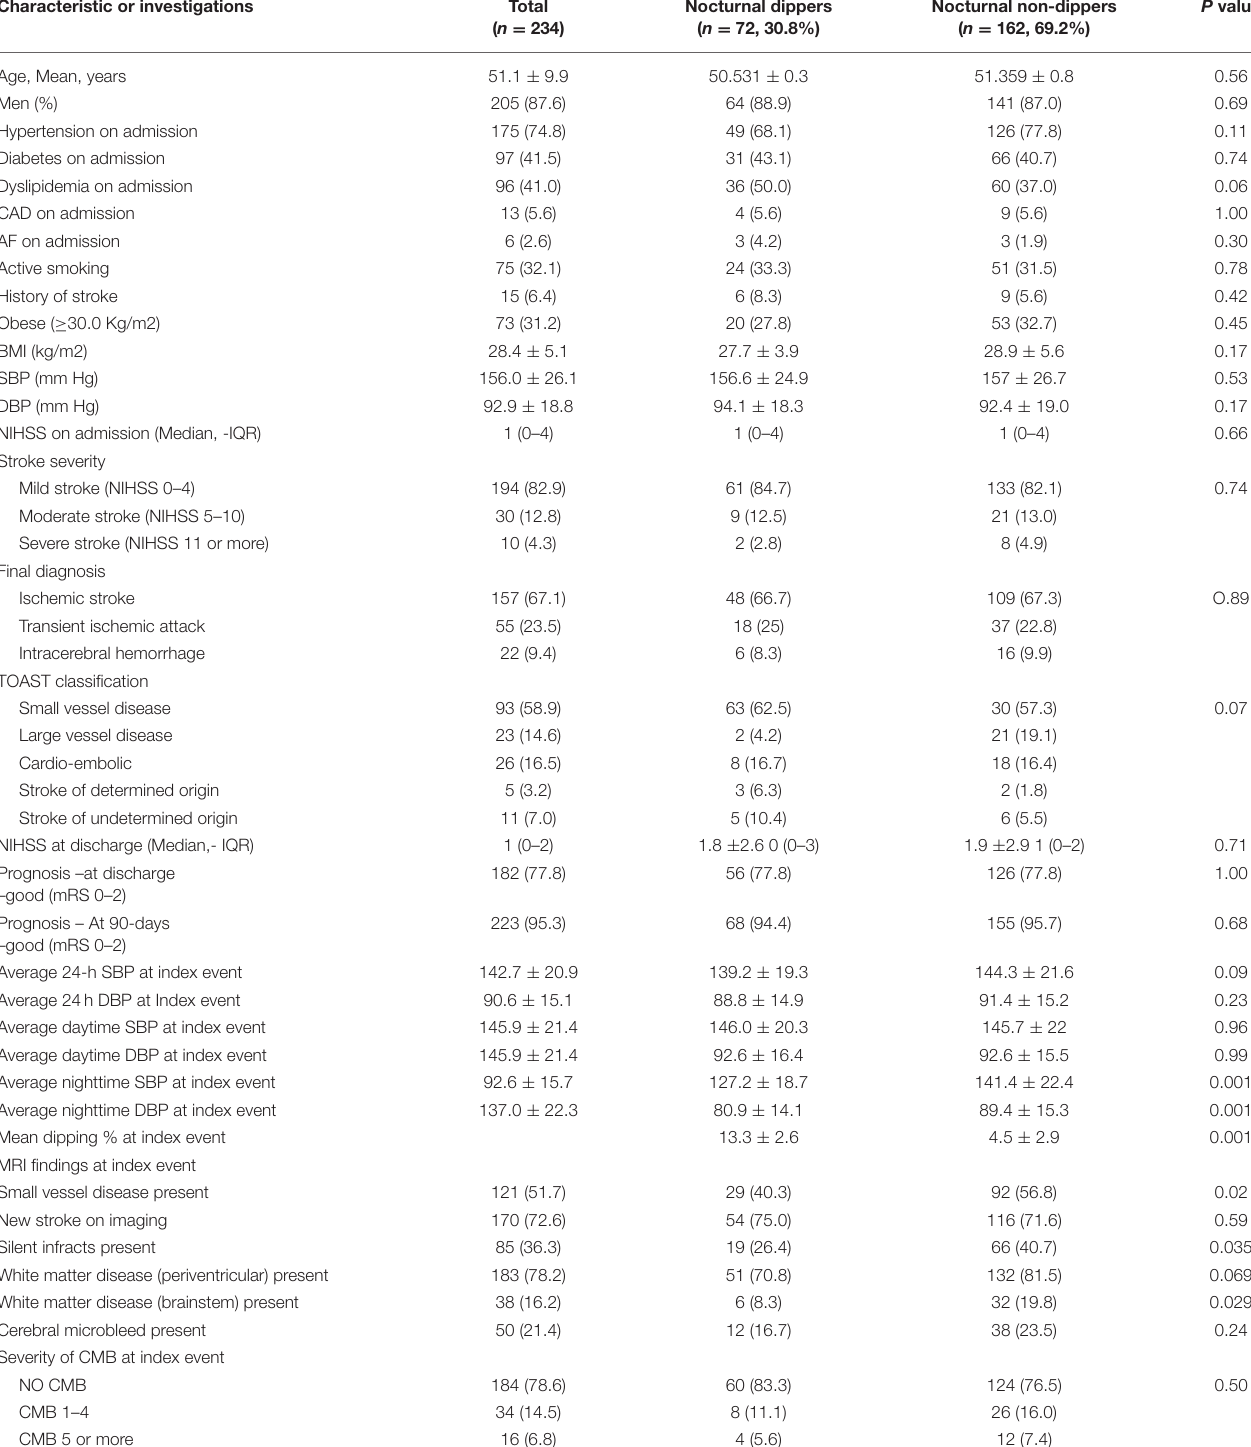
TABLE 1 | Demographic features, stroke severity, outcome, and the presence of SVD in the patients with and without nocturnal dipping. Characteristic or